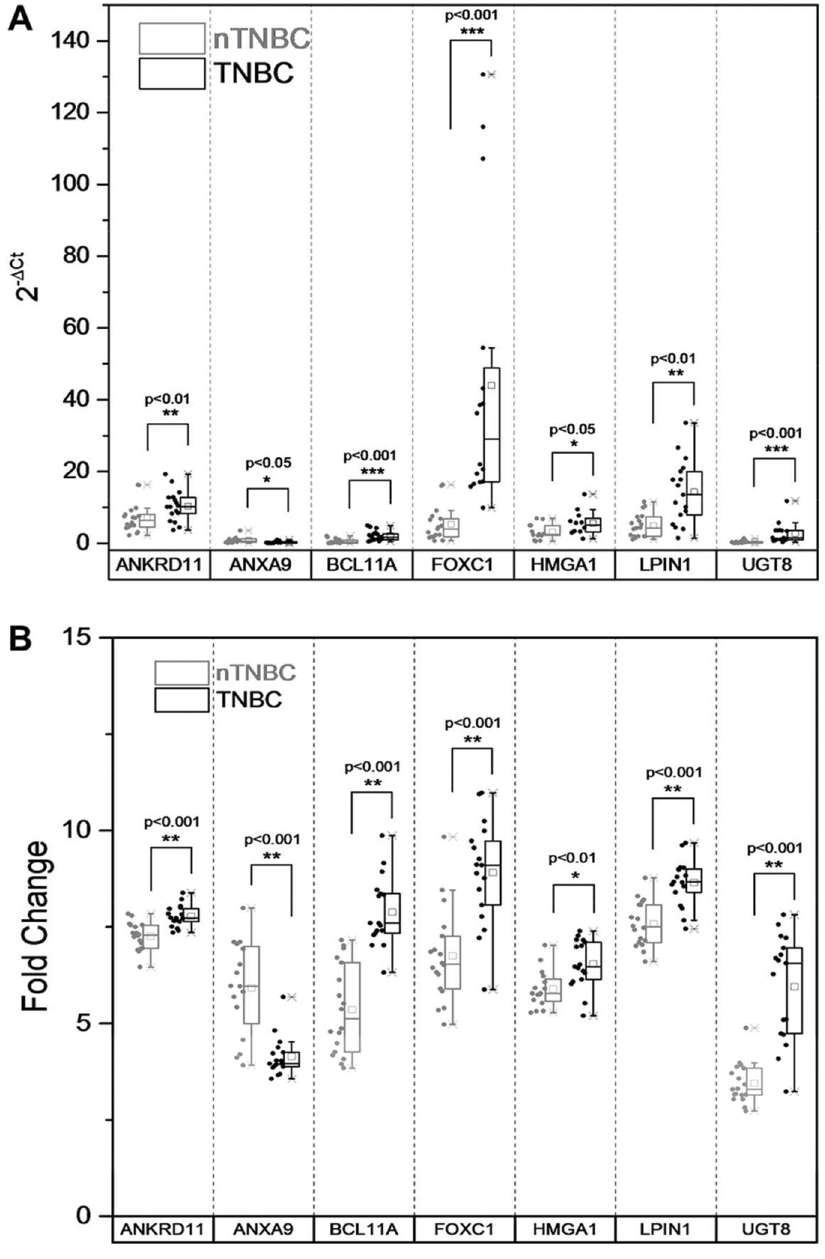
Figure 5. Real-time qPCR validation. Black and gray color show box plots for TNBC (black) and nTNBC (gray). (A) qPCR data (2 -dCt values) from HMGA1, ANKRD11, BCL11A, FOXC1, LPIN1, UGT8, and ANXA9 genes (using GRAMD1A for normalization). (B) Microarray data (fold change) from HMGA1, ANKRD11, BCL11A, FOXC1, LPIN1, UGT8, and ANXA9 genes (using GRAMD1A for